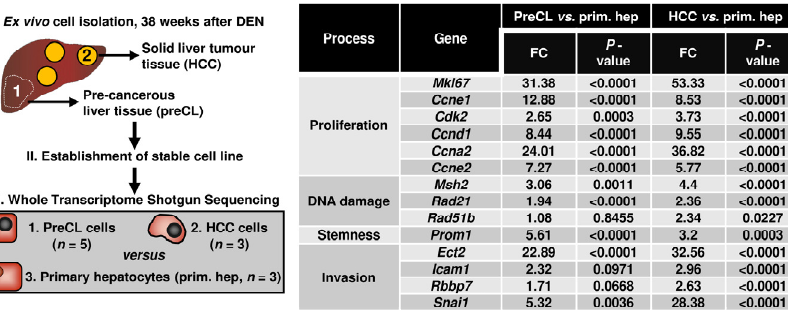
Figure 4. HCC progression after interventional deletion of Ccne1 is characterised by diminished stemness and microinvasion. Two-week-old Mx - Cre transgenic mice with floxed Ccne1 or Cdk2 alleles were treated with DEN. After tumour initiation, mice were repetitively injected with pIpC at week 22 to induce the deletion of Ccne1 or Cdk2 (Ccne1 − / − , Cdk2 − / − ). Mx - Cre -negative mice also received both DEN and pIpC and served as wildtype controls (Ccne1 f/f , Cdk2 f/f ). HCC progression was analysed after week 40. Details are given in Figure 1 and in the method section. L: liver; T: tumour tissue. ( a , b ) Gene expression analysis of alpha fetoprotein ( Afp ) and Prominin 1 ( Prom1 ) in ( a ) CcnE1 f/f and CcnE1 − / − or ( b ) Cdk2 f/f and Cdk2 − / − animals. Ctrl: livers of untreated wildtype mice. Normalised expression levels were calculated as fold induction in com- parison to DEN-treated control livers. Data are expressed as mean ± SD. ( c ) Incidence (%) of venous infiltration (microin- vasion, V1) in CcnE1 f/f and CcnE1 − / − mice. H&E sections (not shown) were analysed for presence of hepatoma cells in ve- nous vessels by an experienced pathologist (N.G., see Supplementary Table S1). ( d ) Gene expression analysis of